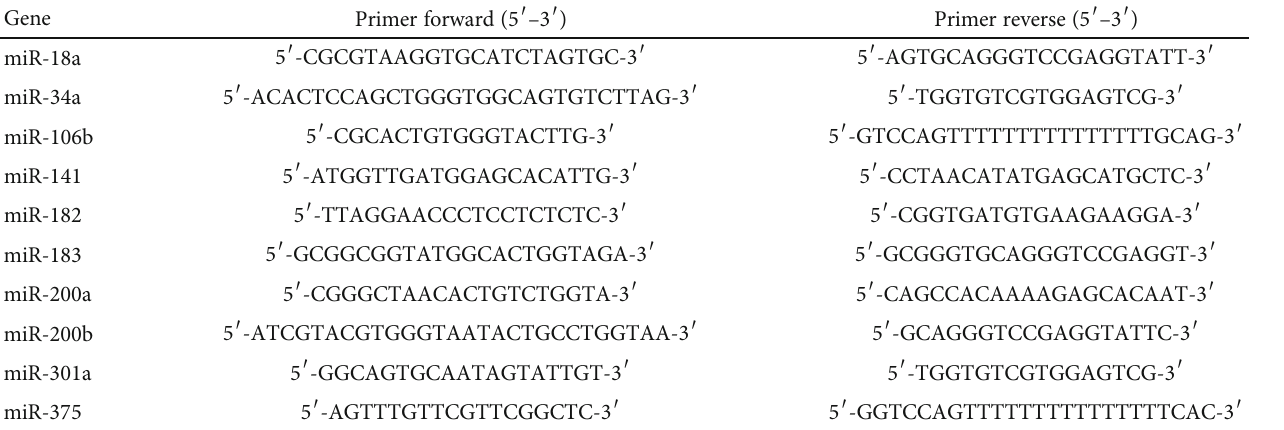
Table 1: Primers used in this study.